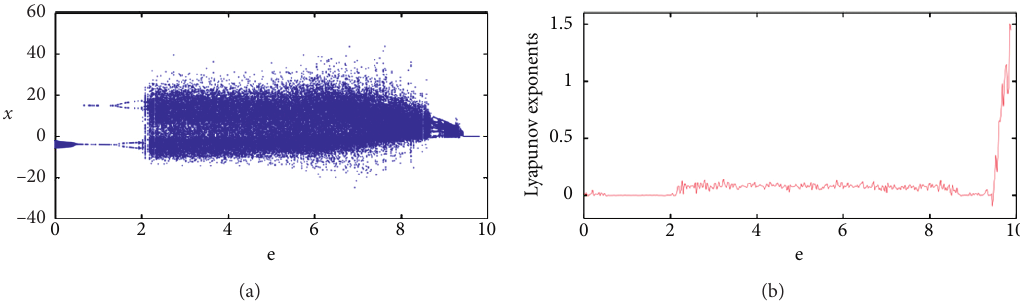
Figure 5: Bifurcation diagram (a) and Lyapunov exponents variation (b) in the total system risk value x with time-lag parameter e .